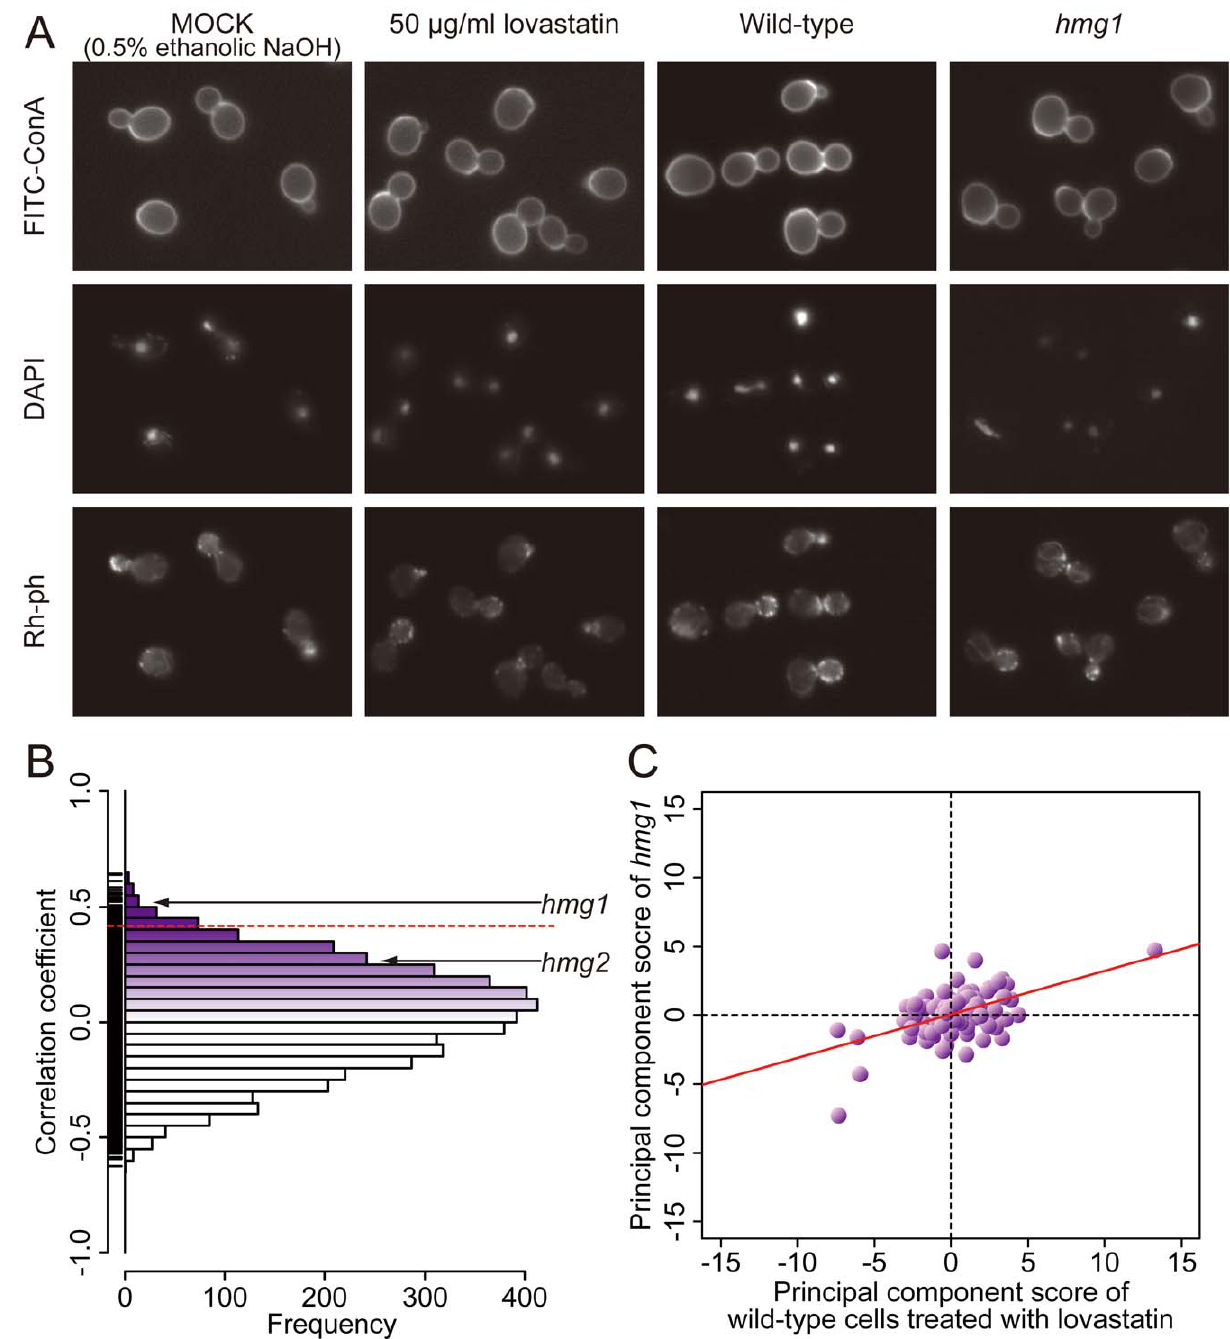
Figure 4. Lovastatin treatment and the results of target inference. A) Photographs of wild-type cells treated with 50 m g/ml lovastatin and the hmg1 mutant. Cells were triply stained with FITC-ConA, Rh-ph, and DAPI. Quantitative analysis of lovastatin-induced morphologic changes is summarized in Table S3. B) A histogram of correlation coefficients (R) between the mutant and lovastatin-treated wild-type cells. The dashed red line indicates the position of the R value corresponding to the two sided P value of 0.05 with the Bonferroni correction based on a correlation coefficient test. C) Two-dimensional plot of lovastatin-treated wild-type cells and the hmg1 mutant. Scores for the 104 principal components are plotted. The red line represents a linear regression model